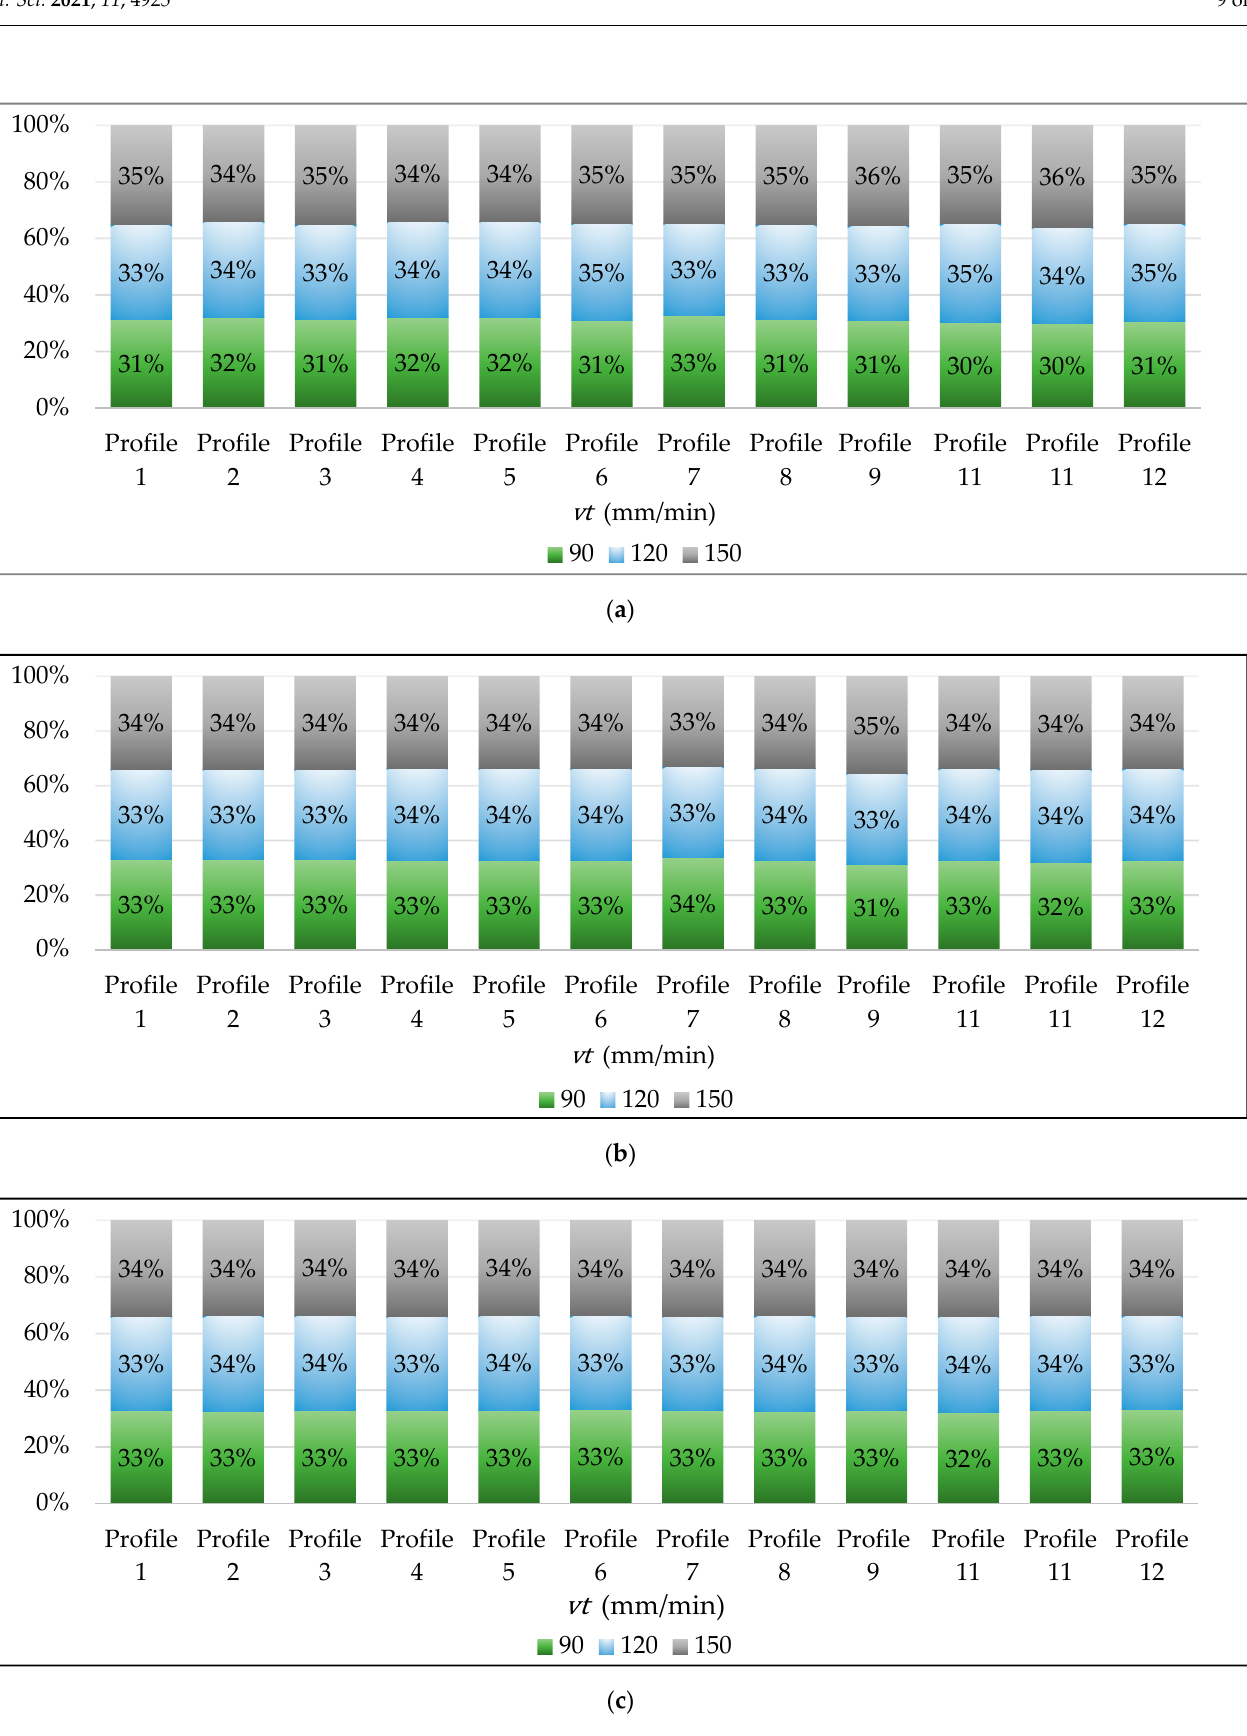
Figure 5. Percentage of variation between top and bottom kerf widths for AISI 304L with material thickness of ( a ) 4 mm, ( b ) 8 mm, and ( c ) 12 mm.